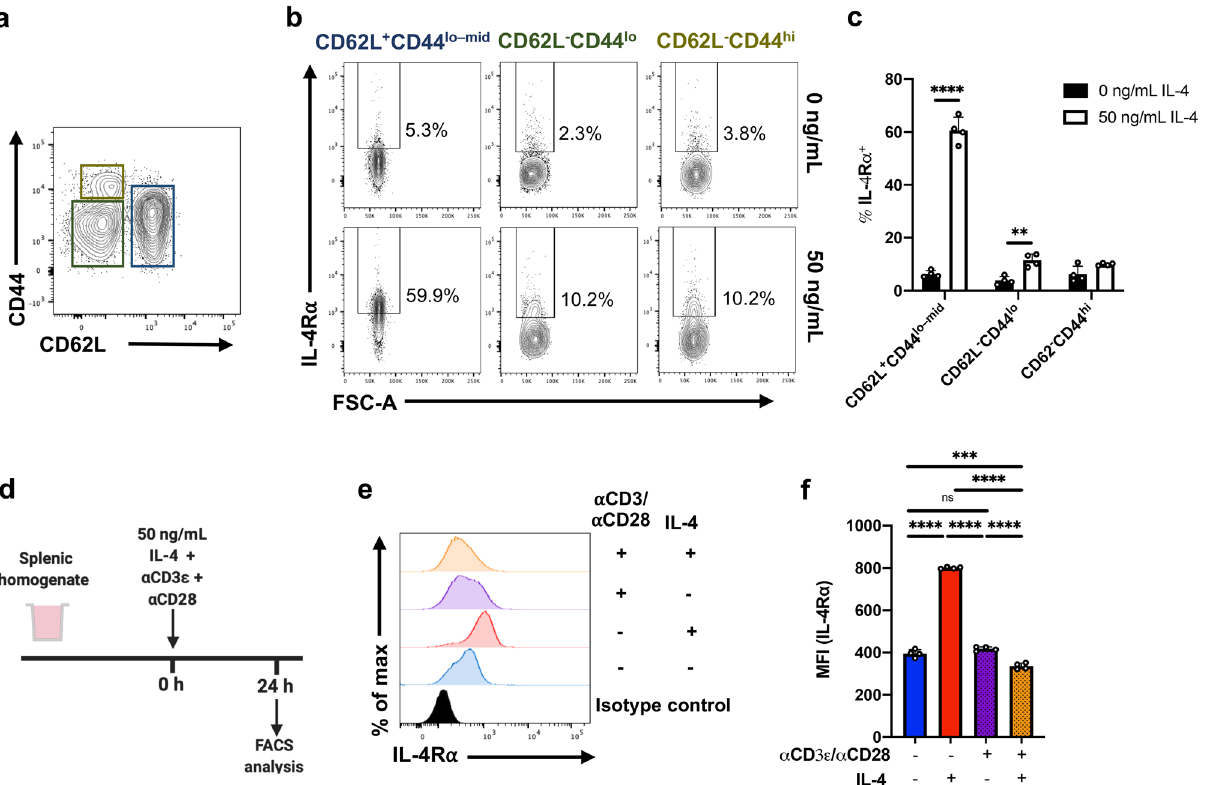
Figure 2. IL-4R ⍺ regulation is dependent on CD4 T cell CD62L:CD44 status. (a) Whole spleen homogenate derived from naïve 6–8-week-old female BALB/c mice ( n = 4) were stimulated with 50 ng/mL IL-4 in vitro for 24 h prior to flow cytometric analysis. CD4 T cells were partitioned based on their CD62L:CD44 statuses. (b) Representative contour plots show the expression of IL-4R ⍺ among CD4 T cells, with respect to CD62L and CD44. (c) The percentage of cells deemed IL-4R ⍺ + following IL-4. (d) Splenic homogenate was seeded with ⍺ CD3ε and ⍺ CD28 and stimulated with 50 ng/mL of IL-4 for 24 h. (e) Representative histograms showing the expression profile of IL-4R ⍺ on CD4 T cells and (f) MFI (IL-4R ⍺ ) for each treatment condition was evaluated. Experiments were repeated three times. Two-way ANOVA combined with Tukey’s post-hoc multiple comparison test was conducted to compare groups. p -value denotations: ‘ns’ p ≥ 0.05, ‘*’ p < 0.05, ‘**’ p < 0.01, ‘***’ p < 0.001 and ‘****’ p <